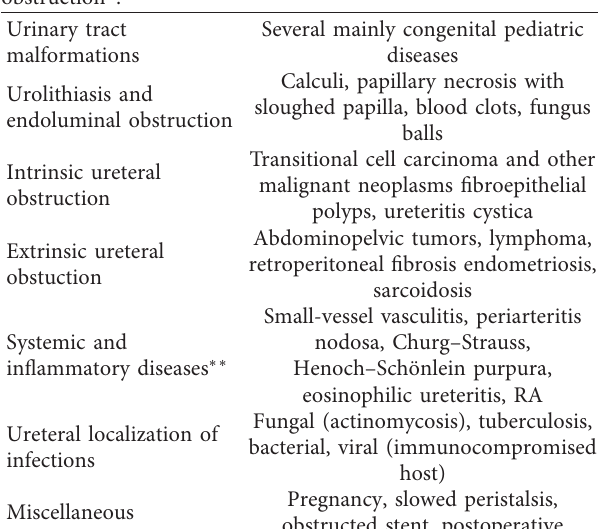
Figure 2: Retrograde pyelography showing bilateral hydro-ure- tero-nephrosis with a complete ureteral stenosis on the right and a partial ureteral stenosis on the left.